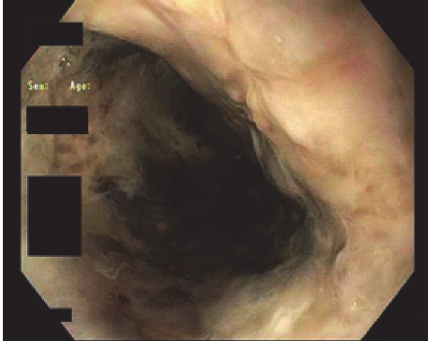
Figure 3: Follow-up endoscopic image (3 days after) of proximal esophagus showing clearing of black color.